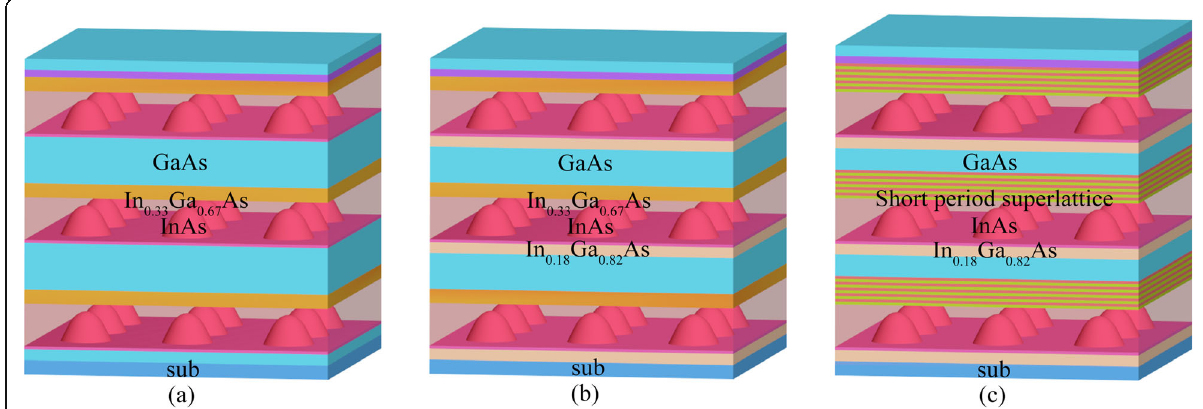
Fig. 1 Schematic diagrams of QD structures. Schematic diagrams of three test structures of a sample 1, b sample 2, and c sample 3,